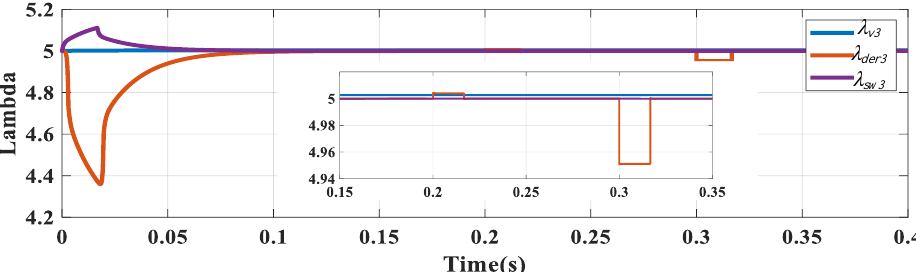
Figure 11. Study 1: generated weighting coefficients for FCS-MPC in DG3.